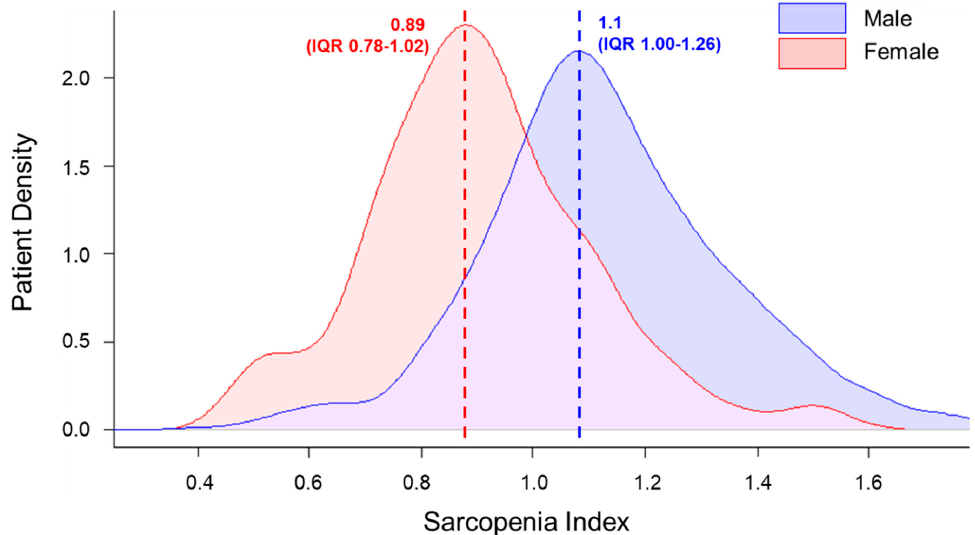
Figure 2. Di ff erent distributions of sarcopenia index depending on sex. Sarcopenia index (SI) ranged from 0.39 to 2.39 (median 1.04, interquartile range (IQR) 0.89–1.19). SI was distributed di ff erently depending on sex; the mean SI was 1.11 (IQR 1.00–1.26) in men and 0.89 (IQR 0.78–1.02) in women ( p < 0.001). SI = sarcopenia index; IQR = interquartile range. Table 1. Baseline clinical characteristics of subjects with the lowest quartile (Quartile 1) and upper